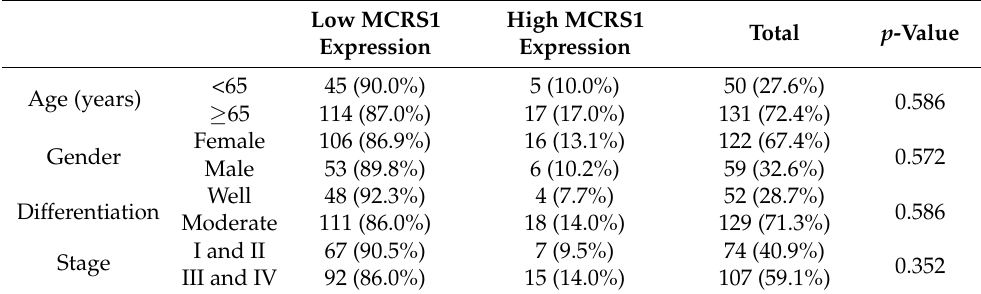
Table 2. Demographics of patients with high and low MCRS1 expression.